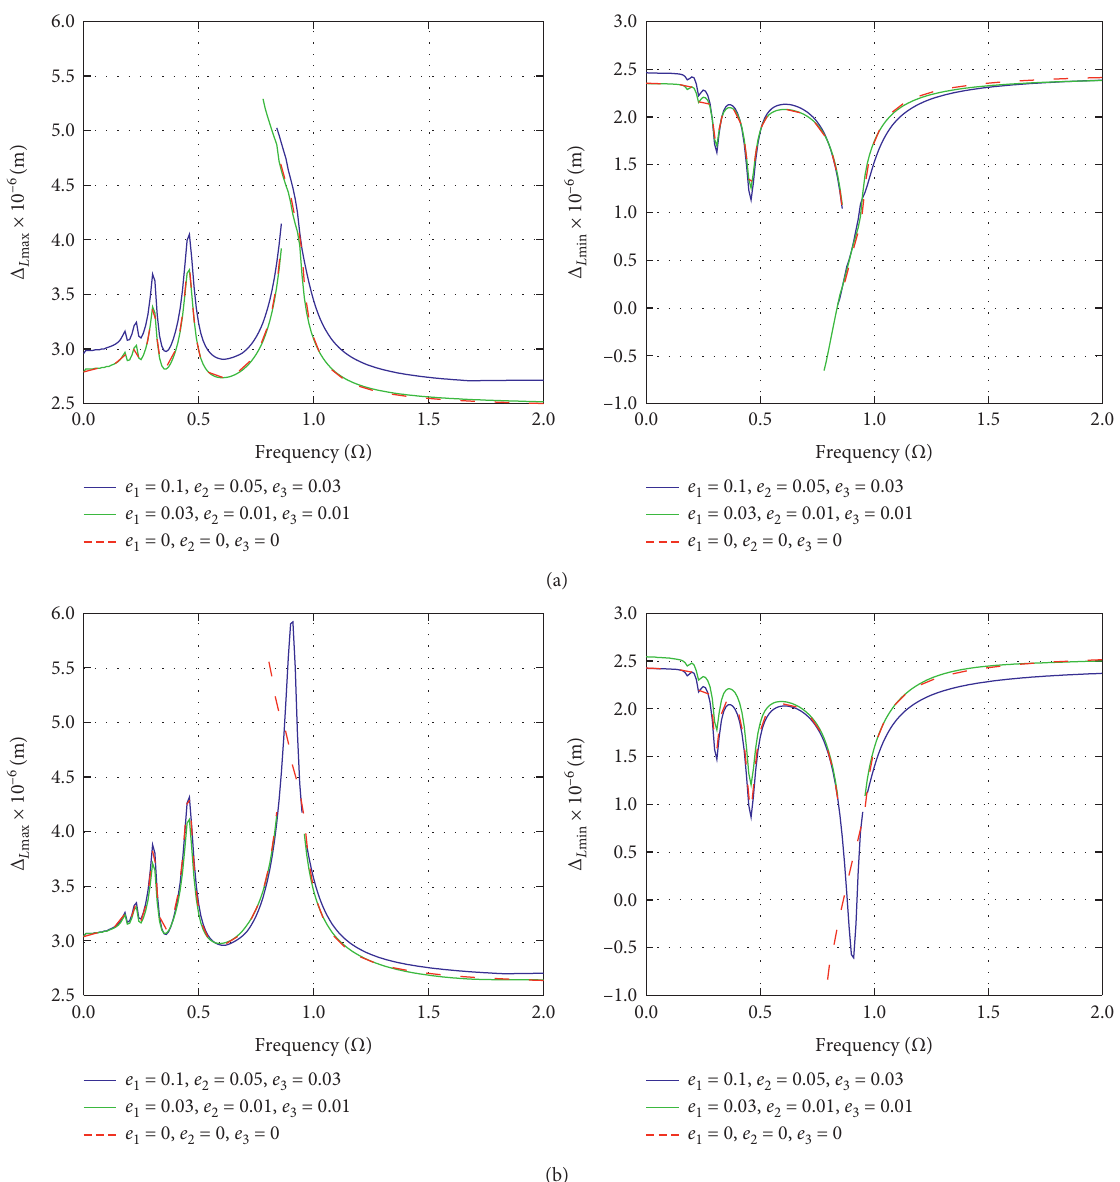
Figure 11: Influence of static transmission error on amplitude frequency characteristic curve of the system. (a) Constant backlash models and (b) dynamic backlash